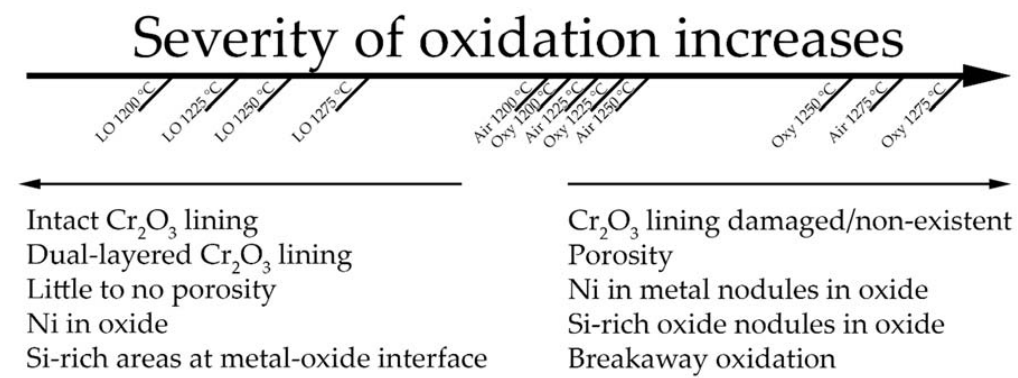
Figure 15. Relative severity of oxidation per atmosphere and temperature. The defining morphological constituents are described and the likelihood of their appearance is denoted by the arrow above the constituent groups. LO = lean oxyfuel, Oxy = oxyfuel, air = air atmosphere.